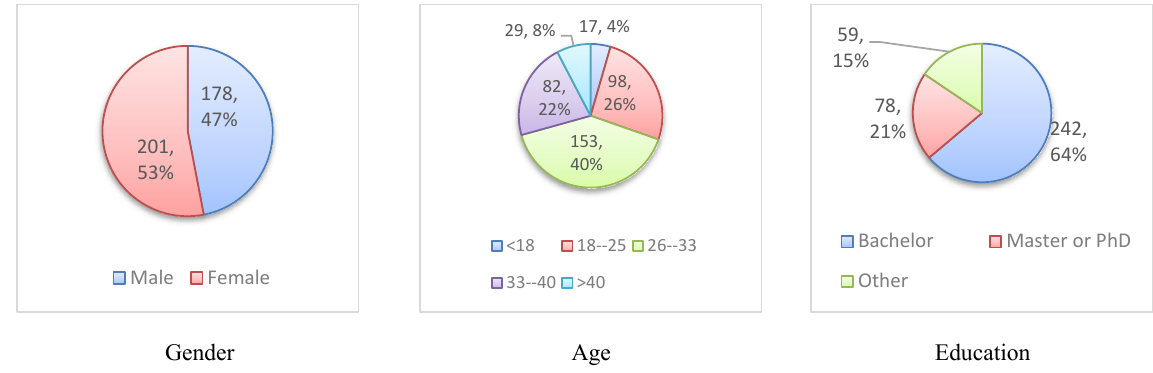
Fig. 2. Personal characteristics of the